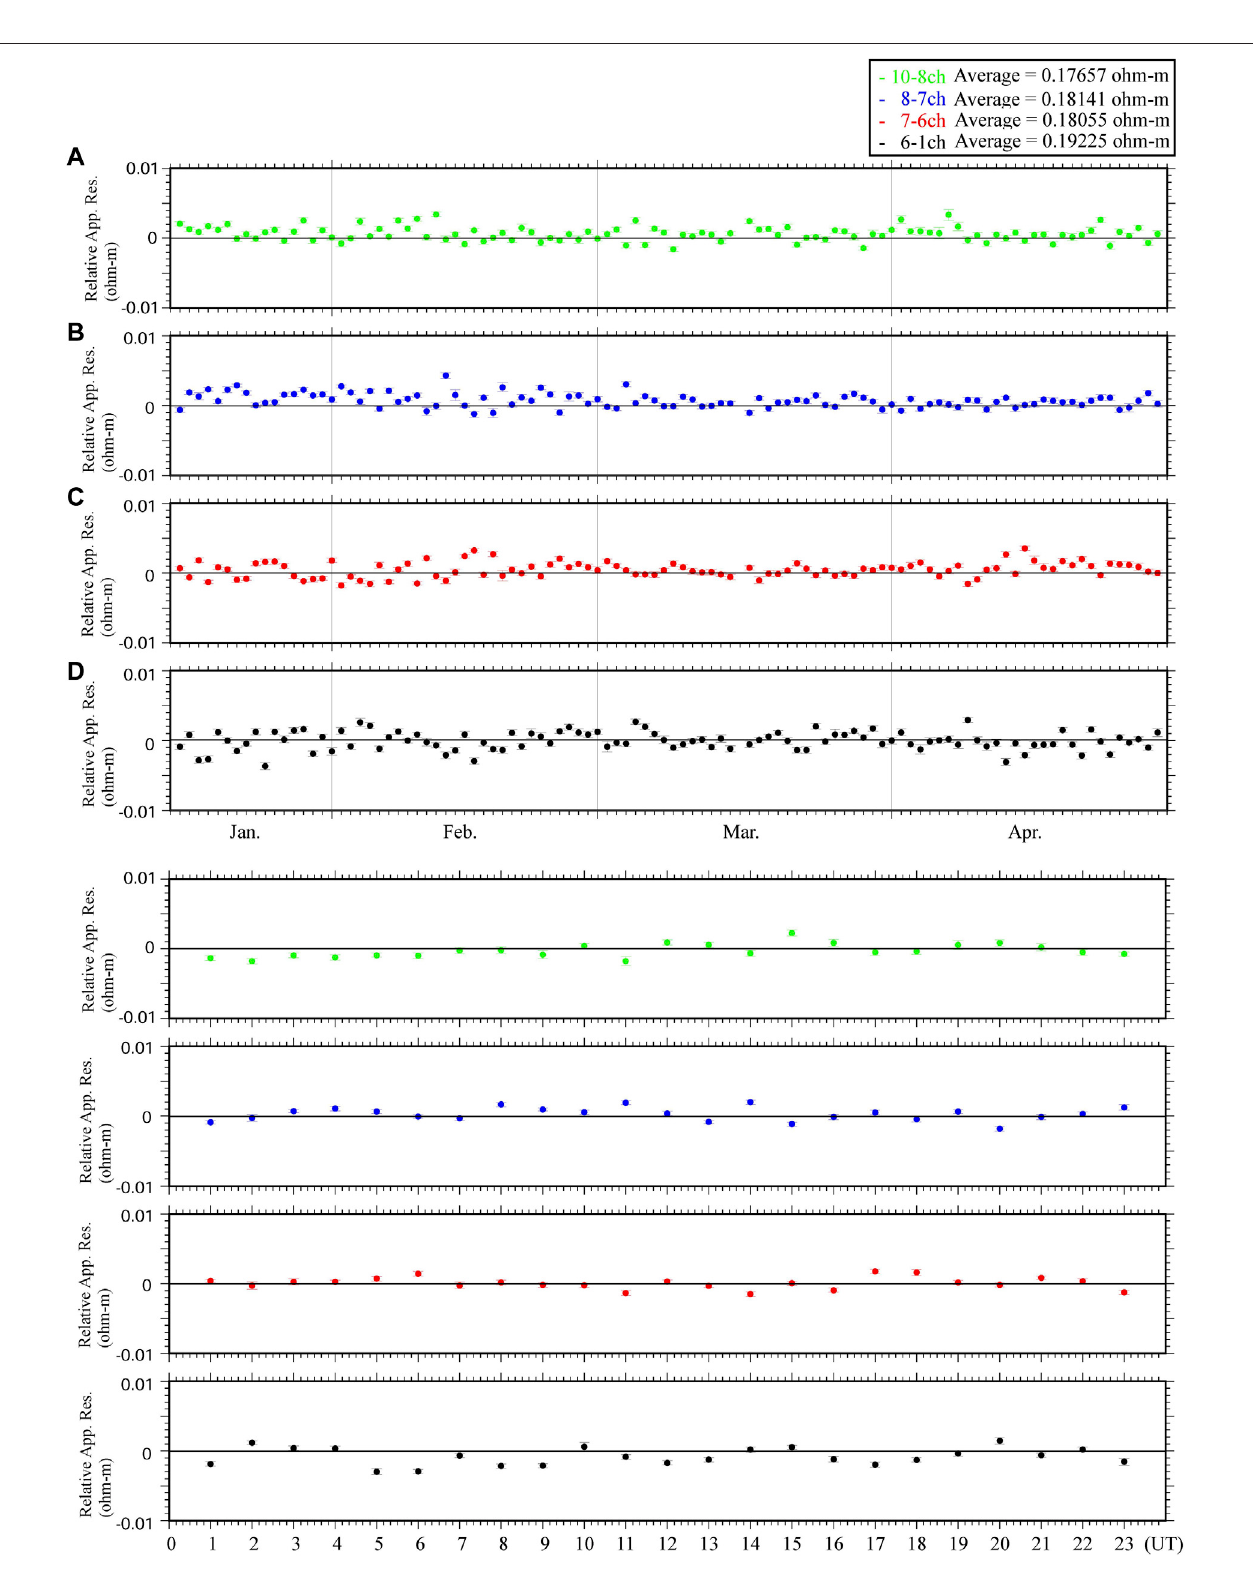
FIGURE7| Timeseriesoftherelativeapparentresistivitycalculatedfromfourelectrodepairsshowninthelegend.Eachaveragedvalueisalsoshowninthelegend. (A – D) Daily mean values throughout the observation period. (E – H) One-hour mean value of the relative apparent resistivity on april 30, 2018. Electric signals were transmitted twice each hour.